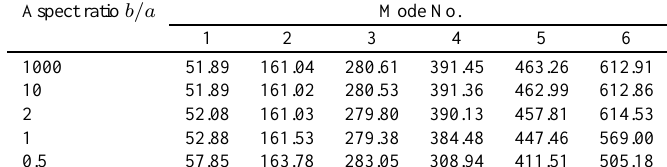
Table 5 Natural frequencies (in Hz) of Clamped-Free elliptical cross-section beam